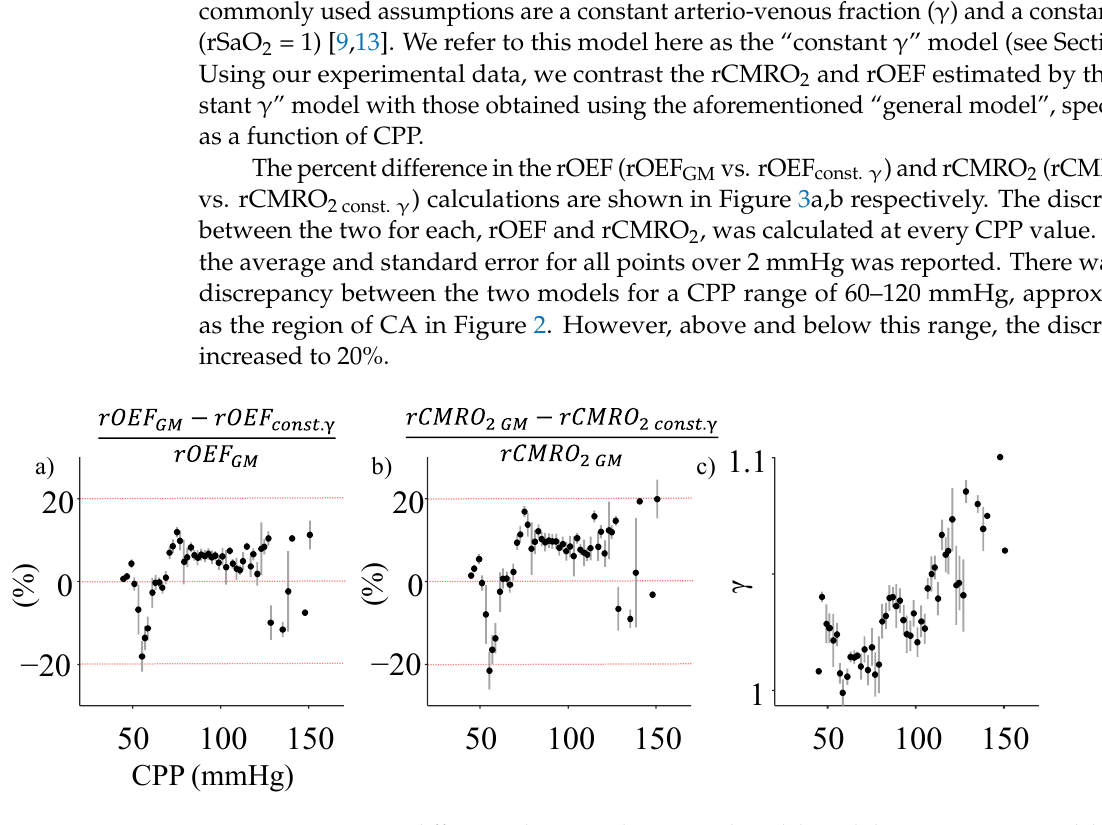
Figure 3. Estimation differences between the “general model” and the “constant γ” model. ( a ) The mean (black dot) and standard error (vertical gray lines) in the percentage difference in rOEF and ( b ) rCMRO 2 is plotted against CPP. The red dashed horizontal line shows 0% and ±20% difference between the methods. ( c ) Changes in γ with CPP. All plots show data averaged across the four subjects.